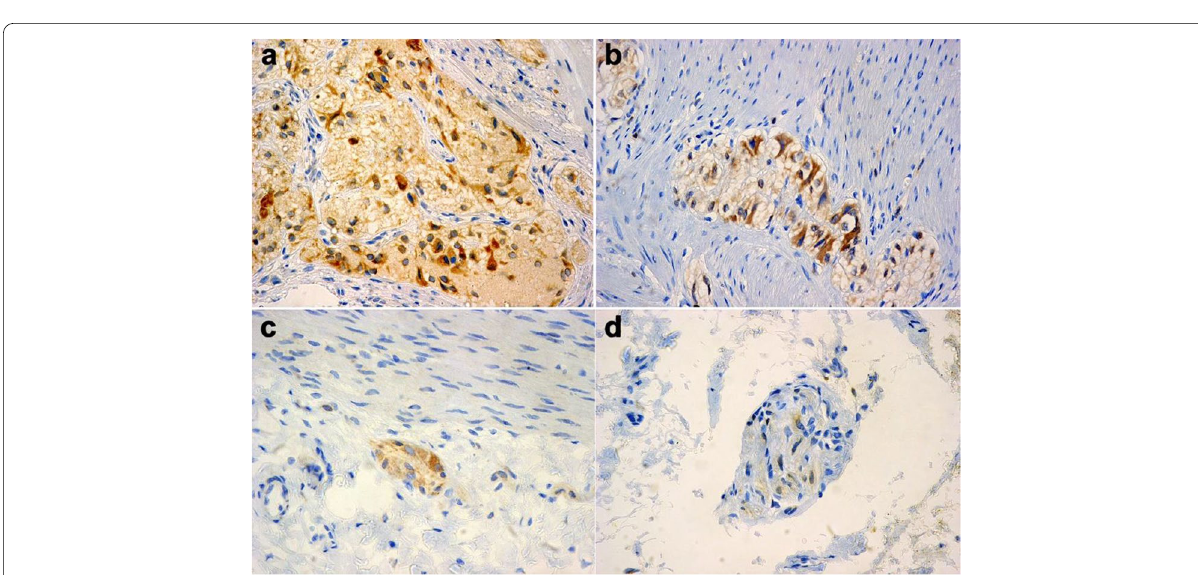
Fig. 5 Bcl-2 immunohistochemical expression in some of the studied cases: a case of IND showing strong Bcl-2 positivity in > 6 immature ganglion cells (IHC score 3 , 400) ( a , b ). A case of post-Hirschsprung’s disease showing weak positivity in one ganglion cell (IHC score 1 + × case of post-Hirschsprung’s disease showing a hypoganglionic with negative staining for Bcl-2 (IHC score 0,